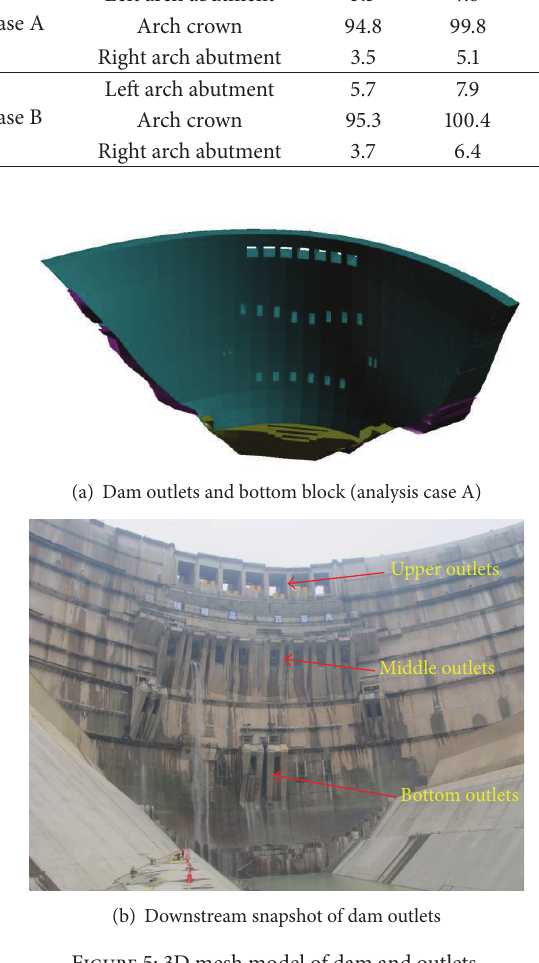
Figure 5: 3D mesh model of dam and